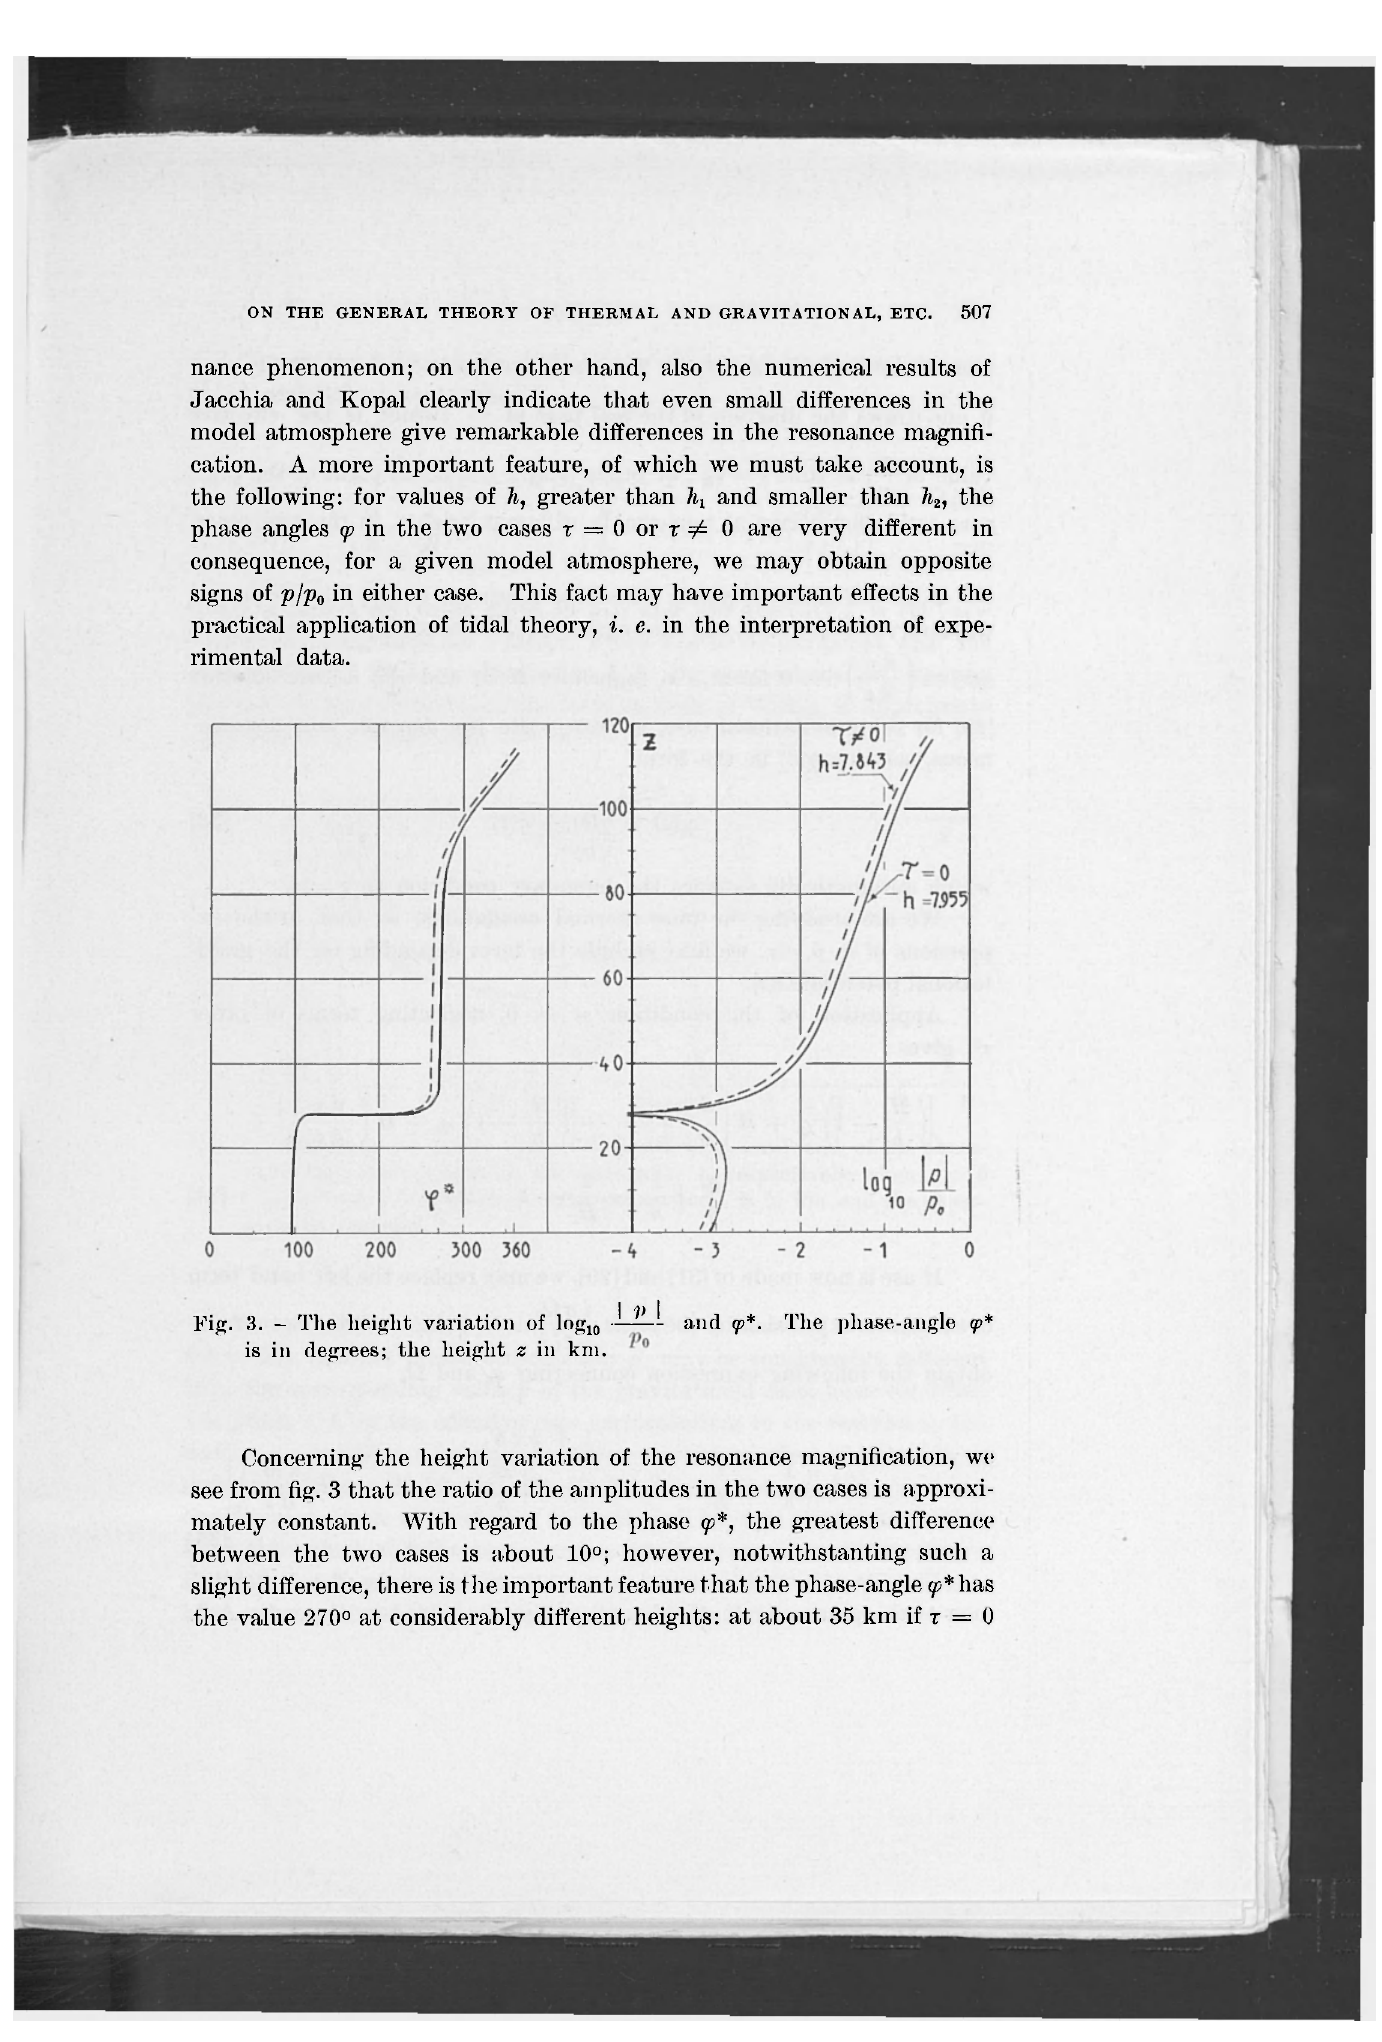
I v I Fig. 3. - The height variation of log 10 —— and <p*. The phase-angle cp* is in degrees; the height z in